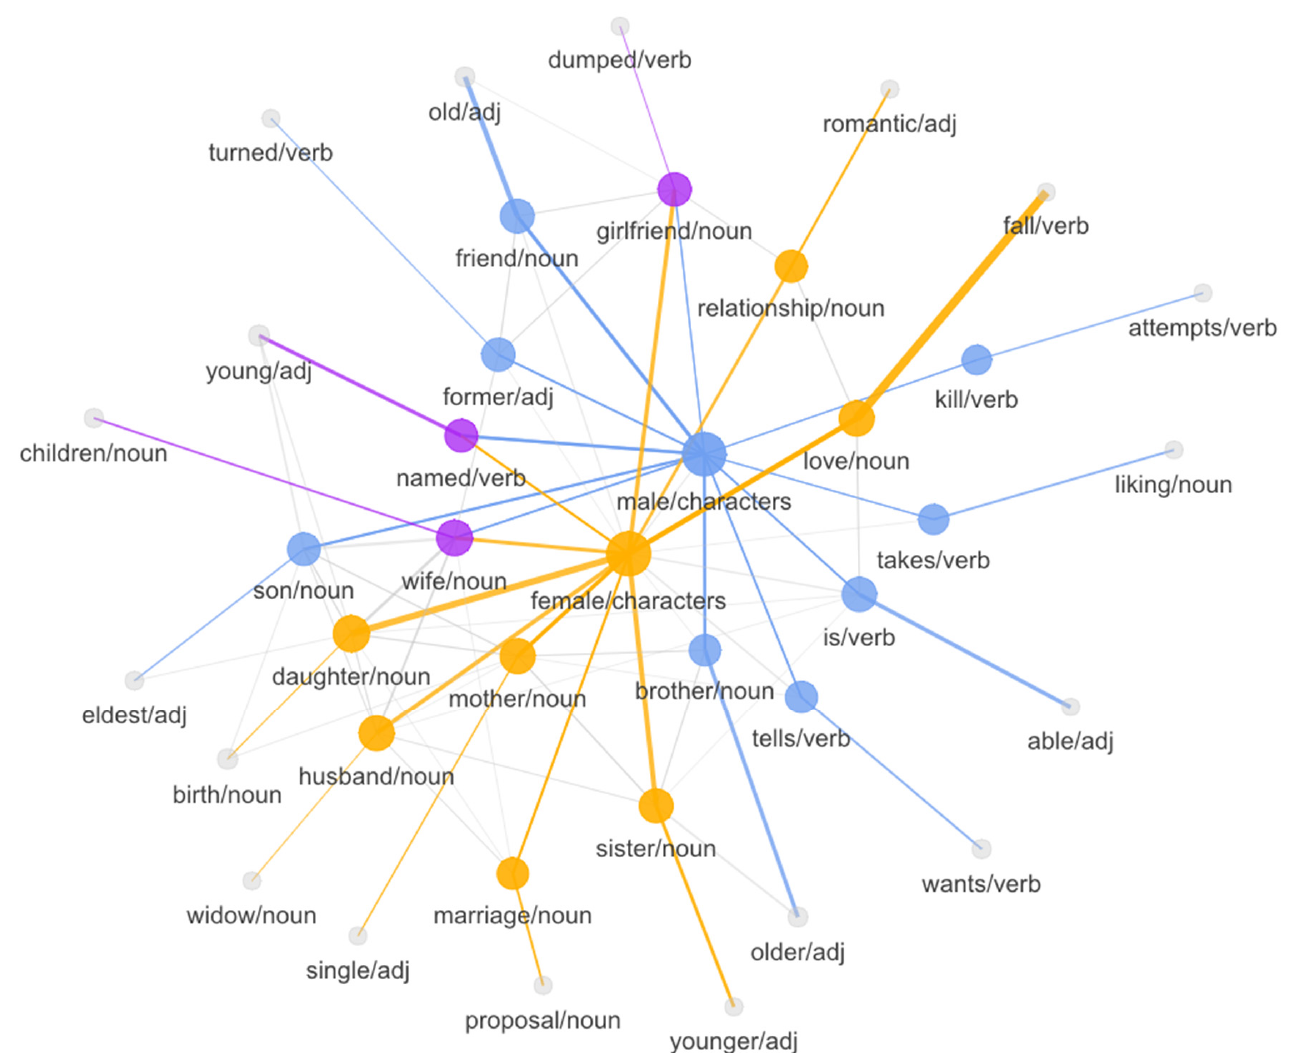
Figure 4. Most significant story tropes associated with male and female characters described by the path ‘character–primary vertex–secondary vertex’. The thickness of the line represents the significance of the log-likelihood ratio. Blue nodes and lines represent unique associations with male characters; orange nodes represent unique associations with female characters. Purple nodes and lines represent the common associations of both male and female characters.